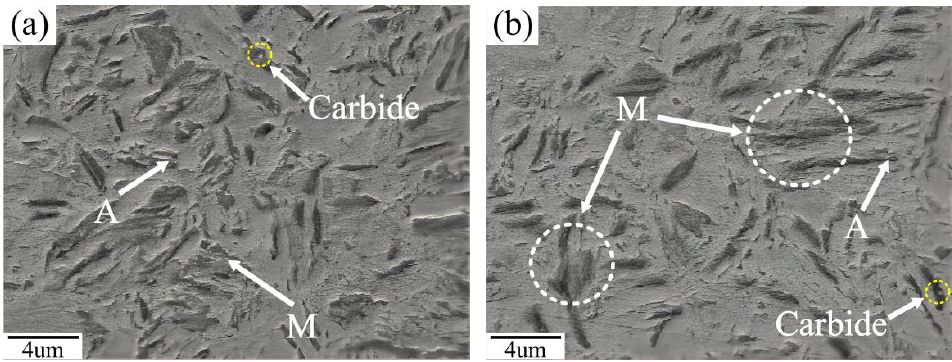
Figure 8. Dislocation density in the surface microstructure of specimens. The SEM image of the sample surface with the control group and the SMGT treatment is shown in Figure 9. The main components of 30CrMnSiA bearing steel are martensite (M), retained austenite (A), and carbide particles. As shown in Figure 9a, the martensite in the surface layer of control group T0 shows short needles. In contrast, the long-needle martensite and martensite beams (marked by white dashed circles) appear in the processed surface layer of groups T1–T5 with the SMGT in Figure 9b–f. Martensite beams are formed by overlapping martensites that are parallel or intersect at certain angles, with twin crystalline relationships between adjacent martensite sheets [30 – 32], which show as dark after corrosion due to there being plenty of crystalline interfaces and overlap.